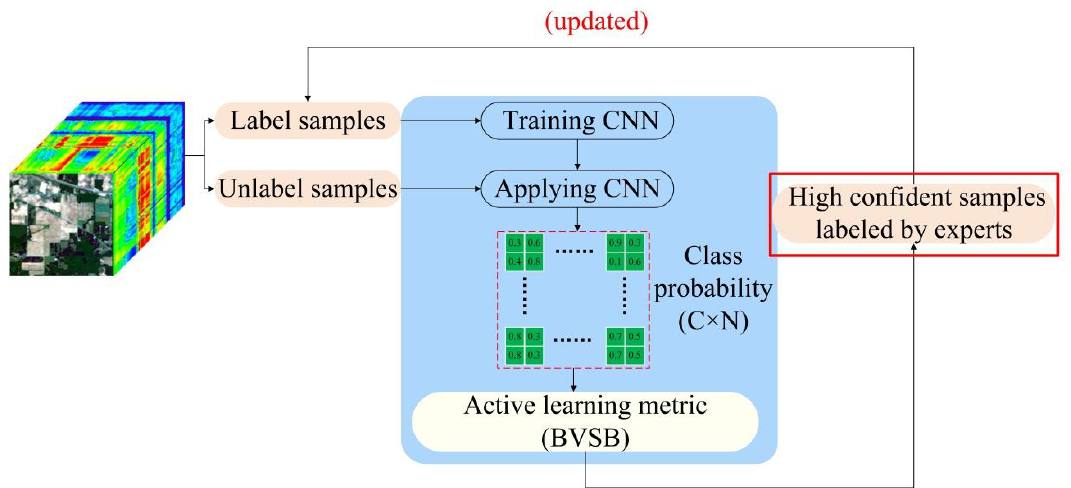
Figure 2. Active deep learning module of the classification model.